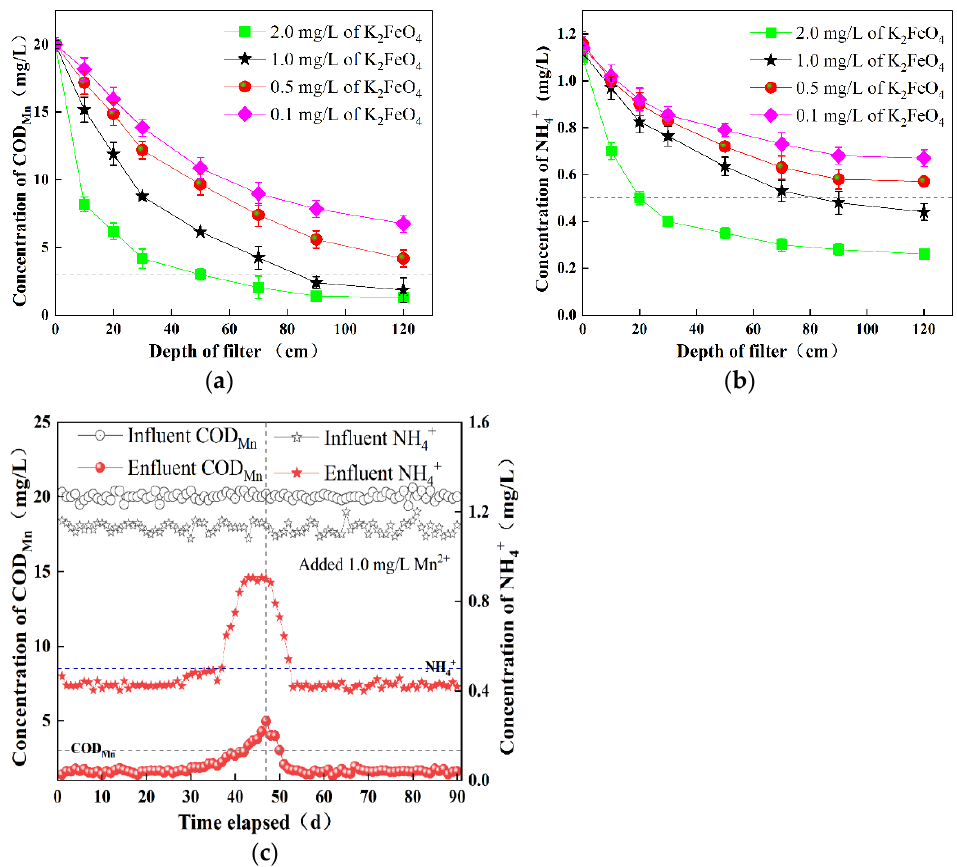
Figure 3. Effect of K 2 FeO 4 concentration on the removal of ( a ) COD Mn and ( b ) NH 4+ ; ( c ) The removal of COD Mn and NH 4+ over the continuous operational period in the pilot-scale filter system.